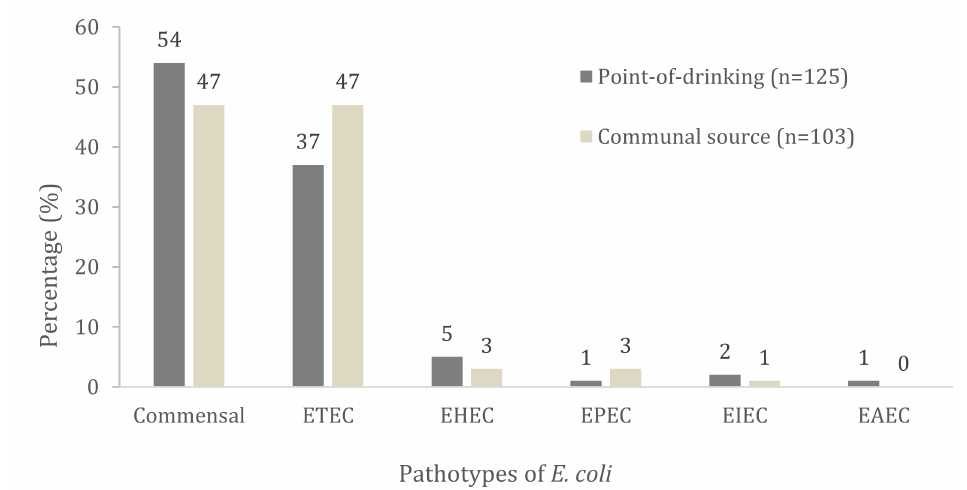
Figure 1. Prevalence of the pathotypes of E. coli in source and point-of-drinking water. Calcu- lated among 228 isolates of point-of-drinking and source water in Arichpur, Dhaka collected